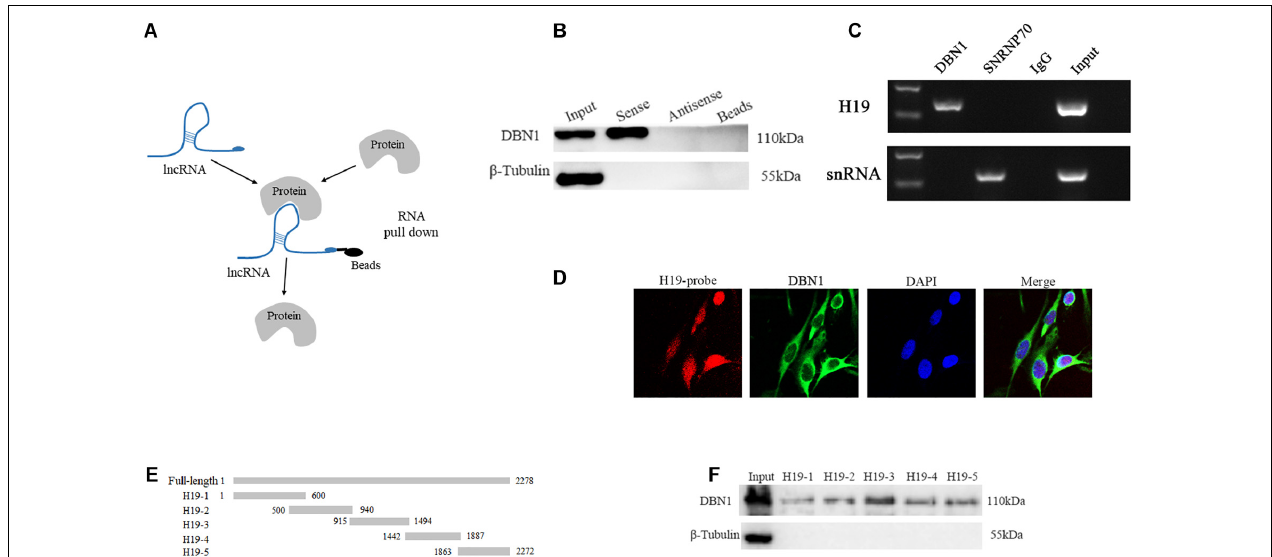
FIGURE 6 | H19 interacts directly with DBN1. (A) A schematic representation of RNA pull-down assay. (B,C) Interaction between H19 and DBN1 as determined by RNA pull-down and RIP. (D) RNA FISH and immunofluorescence staining showed that H19 colocalized with DBN1 in PSCs cytoplasm. (E,F) The interaction of truncated H19 with DBN1 was determined by RNA